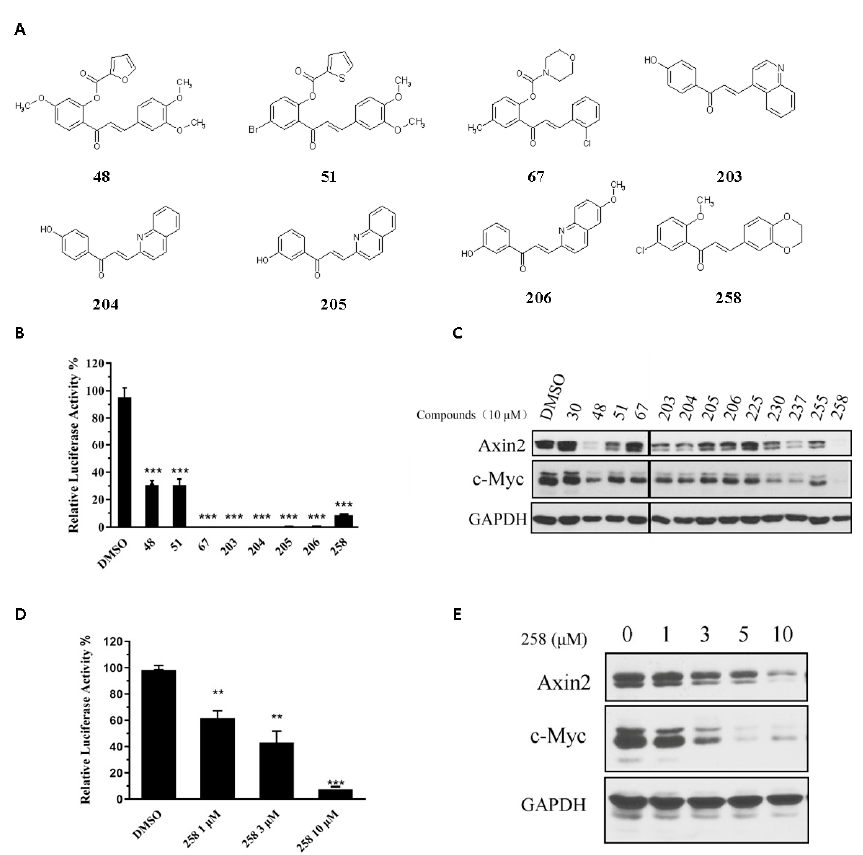
Figure 1. Identification of chalcone inhibitors of Wnt signaling through TOPFlash screening assay. ( A ) Chemical structure of selected chalcone derivatives. ( B ) Chalcone derivatives (10 µ M) inhibited TOPFlash reporter activation. *** p < 0.001 vs. DMSO group. ( C ) Chalcone derivatives (10 µM) re- duced the protein levels of Wnt signaling pathway target genes Axin2 and c-Myc in LS174T cells. GAPDH was used as a loading control. ( D ) TOPFlash reporter assay with di ff erent concentrations of CX258 for 24 h. ** p < 0.01, *** p < 0.001. ( E ) Western blot identi fi ed the inhibitory e ff ect of di ff erent concentrations of CX258 on Axin2 and c-Myc protein levels in LS174T cells. GAPDH was used as a loading control.